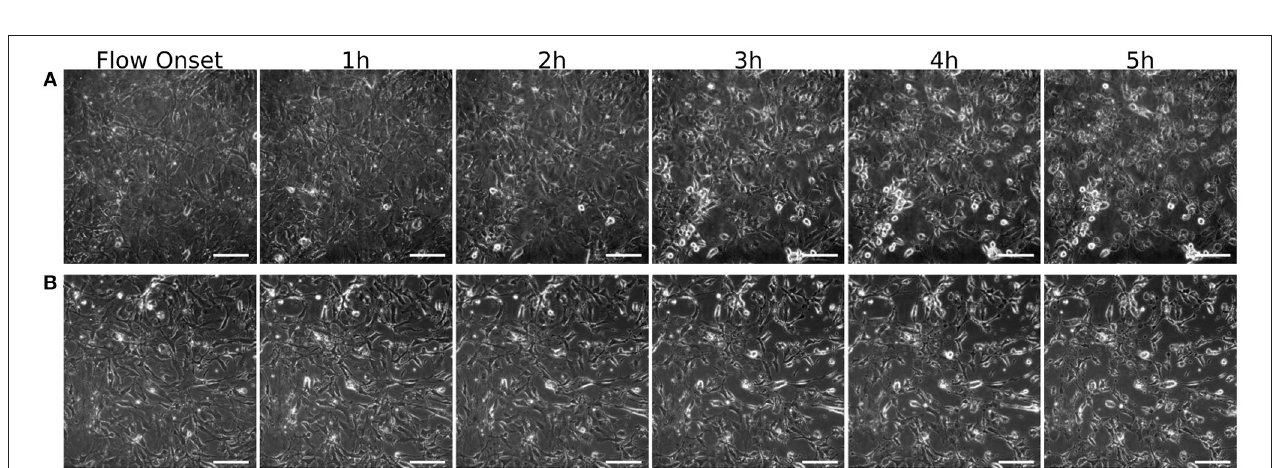
FIGURE 9 | MEC grown on different coatings. Images are taken over 5h at one image per minute at 40x magnification. Shown here are t = 0 at the onset of 6 ml/min flow (0.3Pa WSS), and cells after 1, 2, 3, 4, and 5h of shear exposure. (A) Poly-d-lysine coated glass slides and (B) fibronectin coated glass slides. Scale bar: 50 µ m.